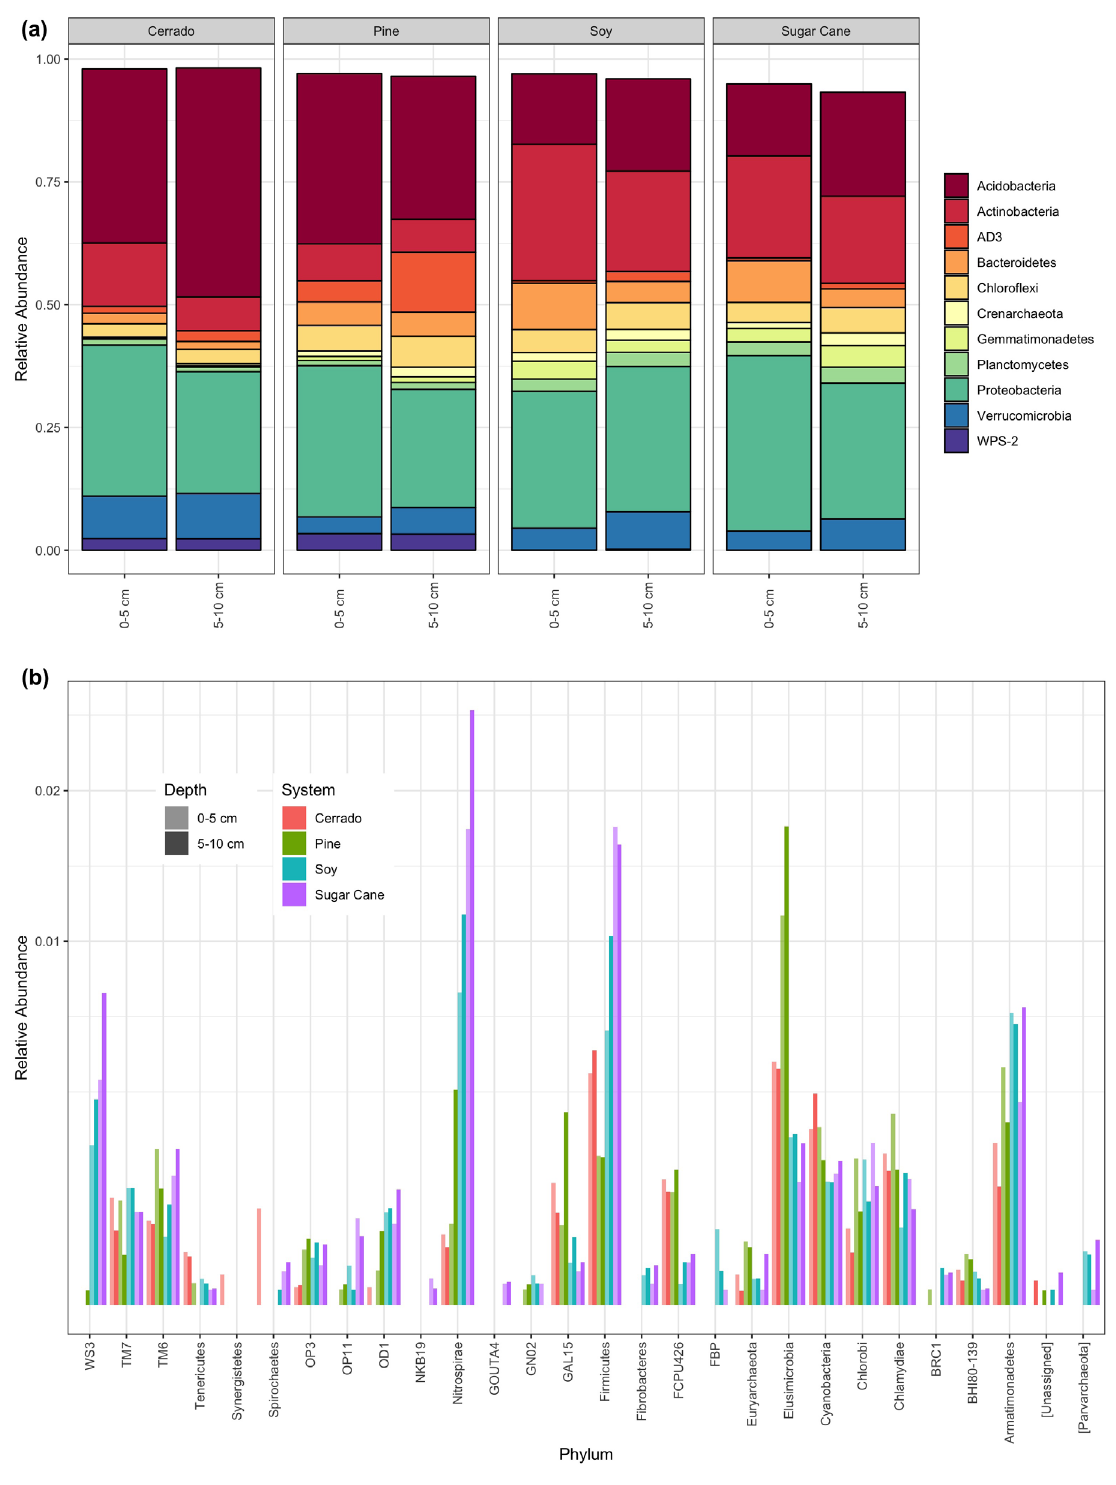
Figure 4 Taxonomic composition of soil bacterial communities in different land use ecosystems and two depths. ( a) relative abundance of phylum greater than 2 %. ( b) relative abundance of rare functional groups smaller than 2 %. Phylogenetic analysis was performed of high-throughput sequencing of 16S rDNA gene at 97% similarly